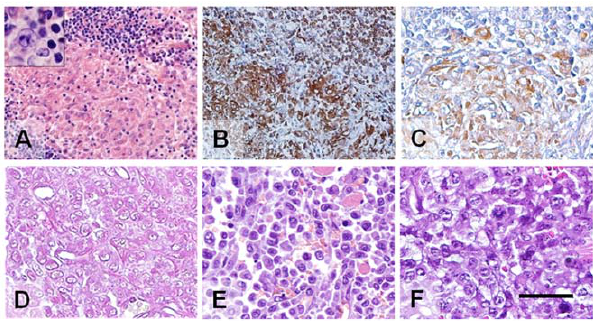
Figure 2. Microscopic morphology of GW-584 human medias- tinal lymphoma and xenografts derived by serial transplanta- tion in the hamster cheek pouch. (A) Sections of the original tumor showed effacement of the lymph node architecture. There was an extensive non-necrotizing granulomatous reaction with rare atypical mononuclear cells (inset) consistent with Hodgkin cells. (B) Immuno- histochemical labeling of the original human tumor identified cells of (B) B/monocyte cell origin (CD74 + ), and (C) activated B cells and granuloma area (CD80 + ). Representative sections of xenografts ob- tained at transplant generations 1 (D), 28 (E), and 57 (F) show a constant uniform morphological appearance over time. The tumor is composed of large transformed lymphoid cells with vesicular nuclei and prominent nucleoli. Scale bar in F corresponds to 100 m m for images in C, D, E, and F, as well as the higher magnification inset within image A, and 400 m m for images in A and B.